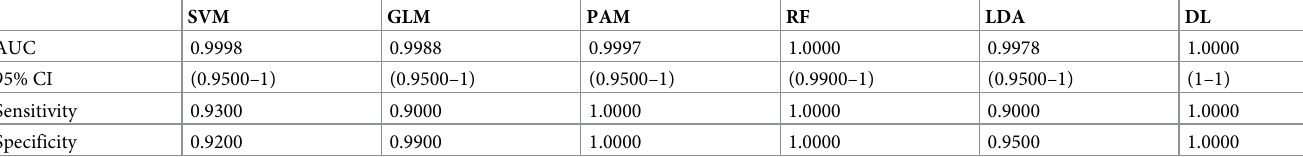
Table 1. Results of Term Autism Placenta based on combined Inter and intragenic markers (with FDR p-value <